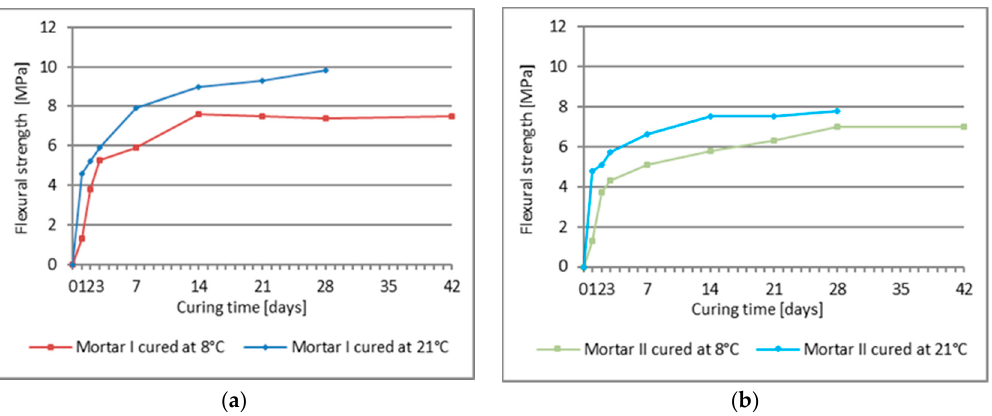
Figure 4. Flexural strength of mortars cured at 8 °C and 21 °C, following subsequent curing periods (average value): ( a ) mortar I, ( b ) mortar II.